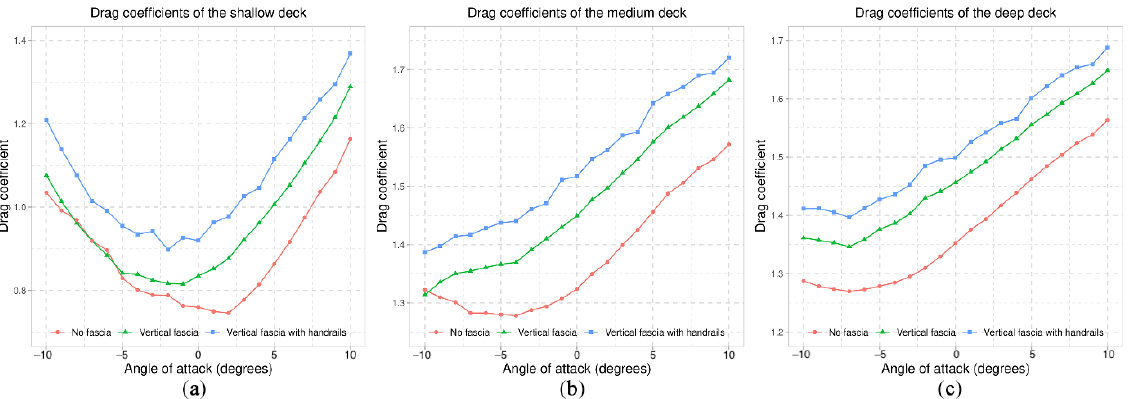
Figure 28. Change in drag coefficients with the inclusion of vertical fascia beams and handrails for the ( a ) shallow deck, ( b ) medium deck, and ( c ) deep deck.